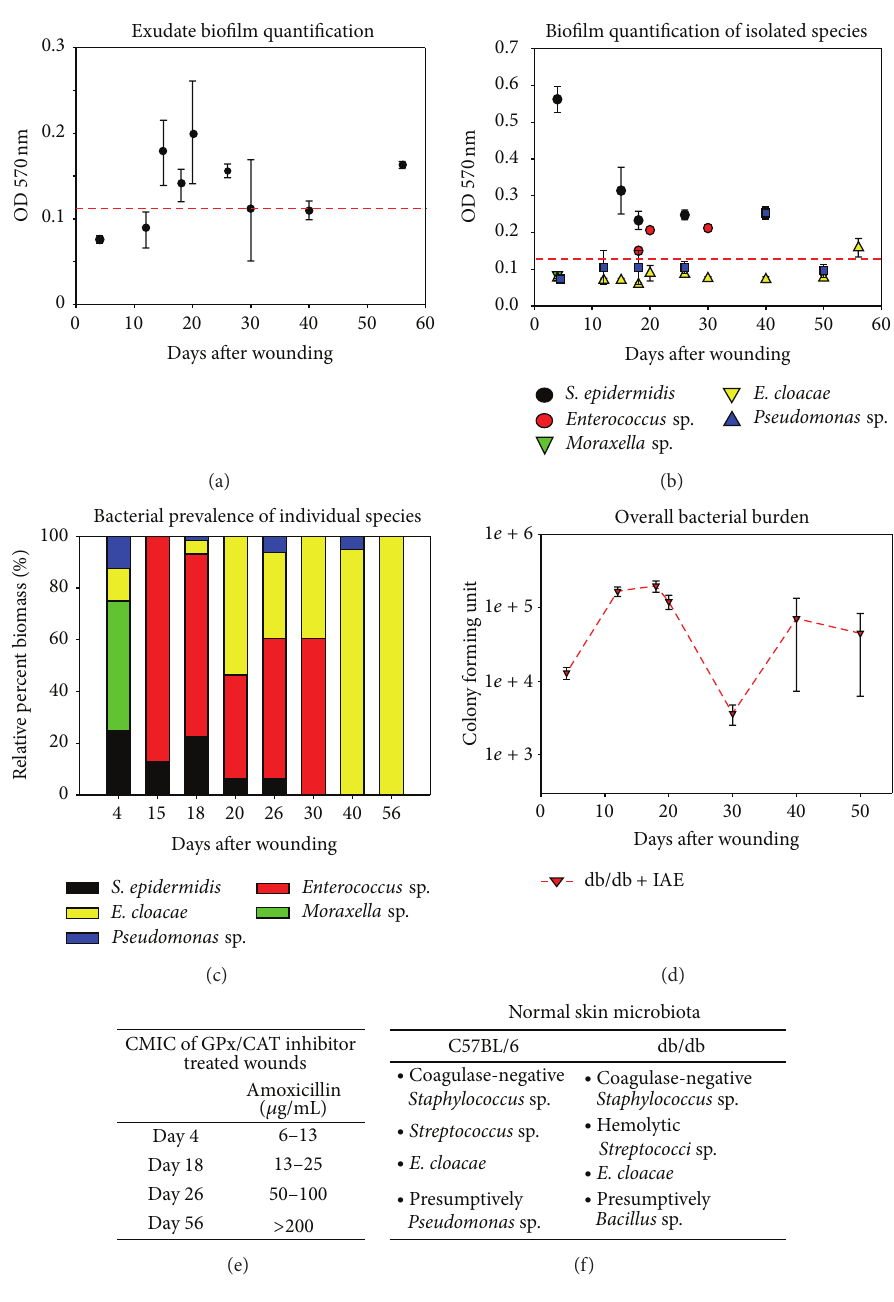
Figure 3: Chronic wounds contain complex antimicrobial-resistant wound microbiota. (a) Bacterial contents of in the swab sample were quantified by measuring the optical densities of stained bacterial films at OD 570 nm ( ≥ 0.125 is considered to be biofilm positive—dashed red line). (b) Specific bacterial strain identification shows a dynamic presence of different species with biofilm-forming-capacity. (c) Bacterial prevalence of individual species shows the changing dynamics of the wound microbiota. Quantifying the relative percentage of individual bacterial species demonstrated that Enterococcus sp. and S. epidermidis made up the large majority of the microbial mass with traces of Pseudomonas and E. cloacae at 4 days after IAE treatment. At day 20, the majority of the biomass was composed of